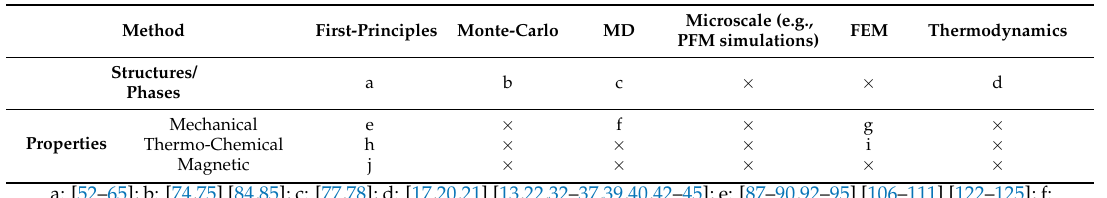
Table 3. The reviewed computational modeling methods used to study the structures and properties of MPE